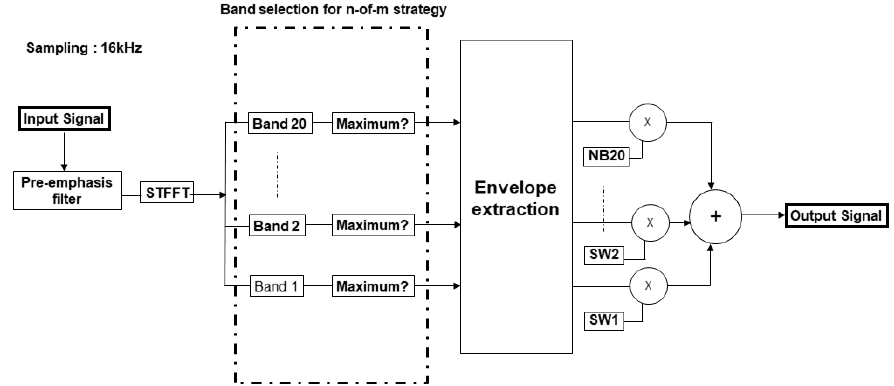
Figure 1. Block diagram representing the signal processing performed by the n-of-m simulator.